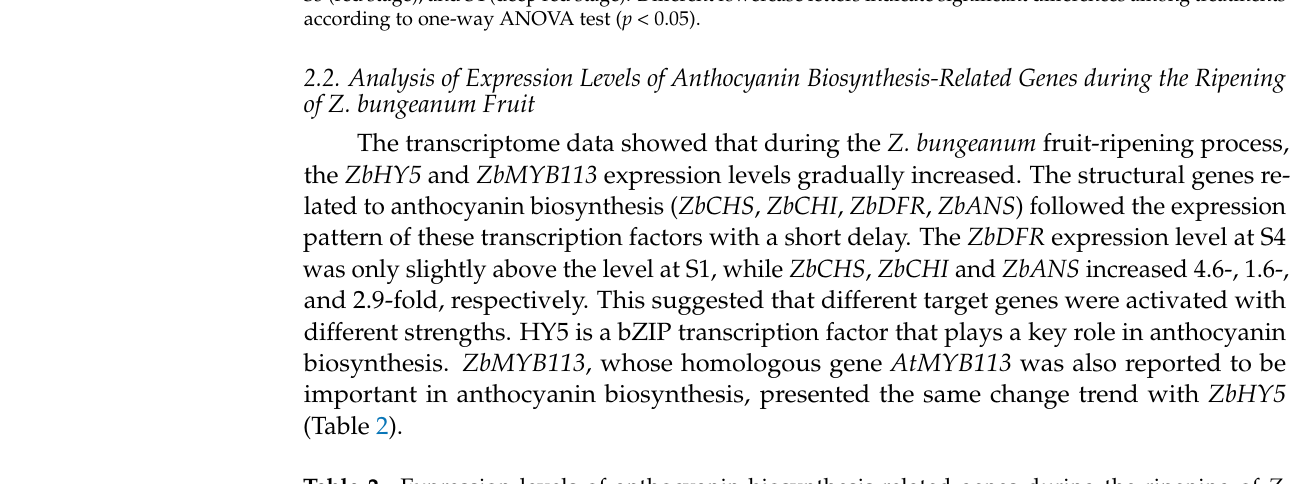
Table 2. Expression levels of anthocyanin biosynthesis-related genes during the ripening of Z. bungeanum